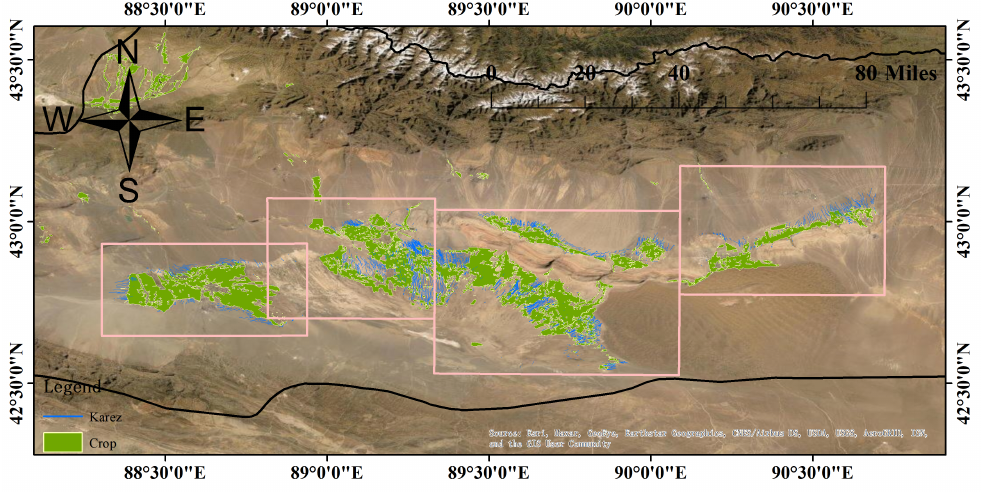
Figure 14. Overlay of the karez line and crop map in the Turpan Basin.